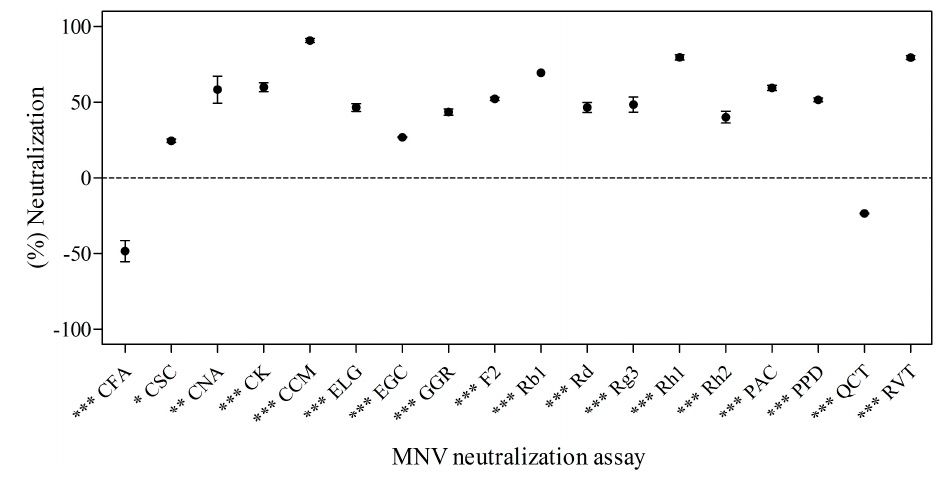
Figure 1. The effect of phytochemicals on murine norovirus (MNV) neutralization in RAW 264.7 cells. MNV was mixed with 1 mg/mL of 18 phytochemicals and stored for 72 h at 4 °C. DMSO was used as a vehicle control and virus titer was measured by plaque assay. The mean diameter of plaques was 1 mm, and visible plaques were counted 72 h after infection. Each point was derived from triplicate determinations. Results are expressed as percentage neutralized virus compared to a vehicle control (mean ± SEM). Statistical significance was determined based on ANOVA with Bonferroni post-tests. * p < 0.05; ** p < 0.01; *** p < 0.001 compared to vehicle control.